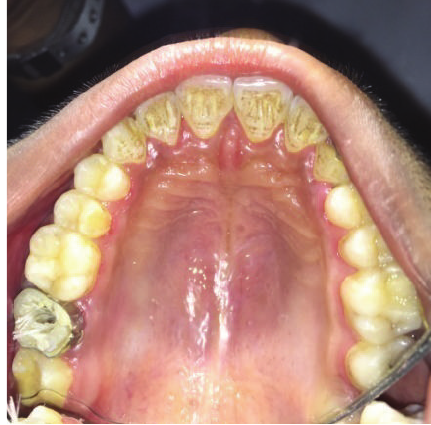
Figure 13: Photograph showing 3 mm placement of Ribbond in the canal.